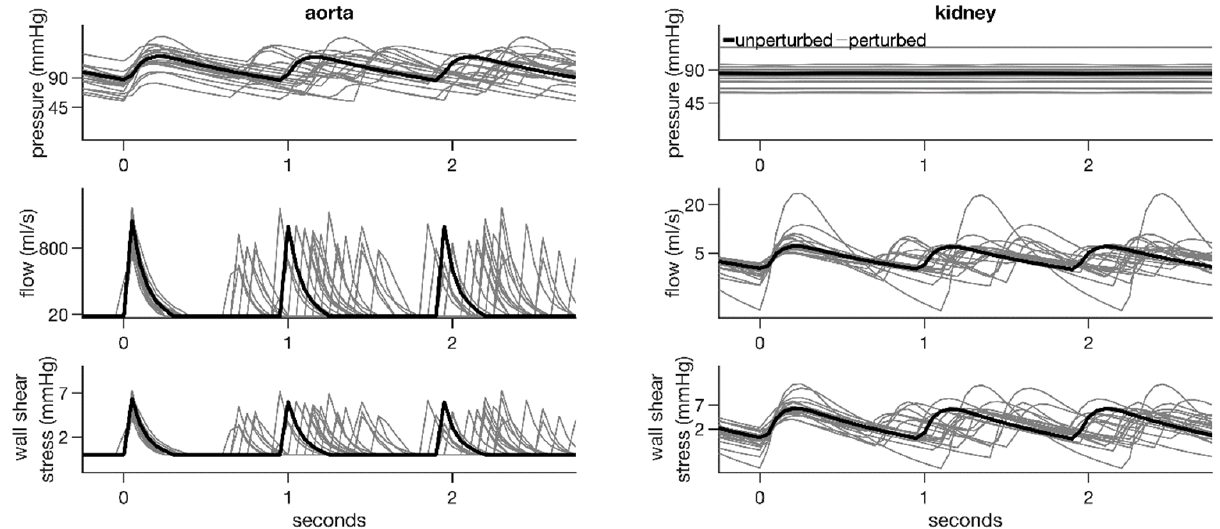
Figure 3. Representative profiles from the baseline simulated pressure ( top row ), blood flow ( middle row ), and wall shear stress ( bottom row ). Left column shows data for aorta and right column shows data for right kidney. In all panels, black lines show unperturbed simulation, while gray lines show instances from the population simulations obtained by perturbing parameters. See Section 2.2 for the method used to generate populations.